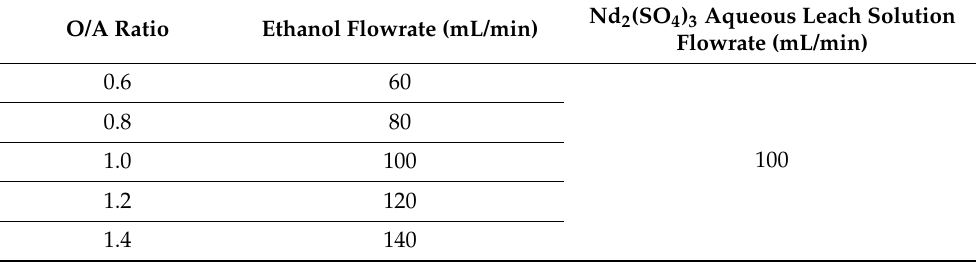
Table 1. Flowrates of reagents at different O/A